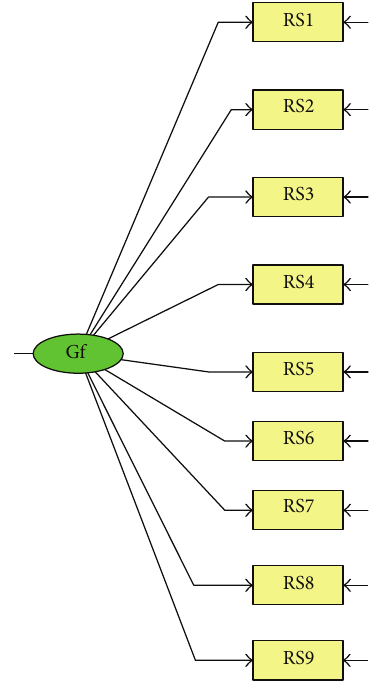
Figure 1: One-factor